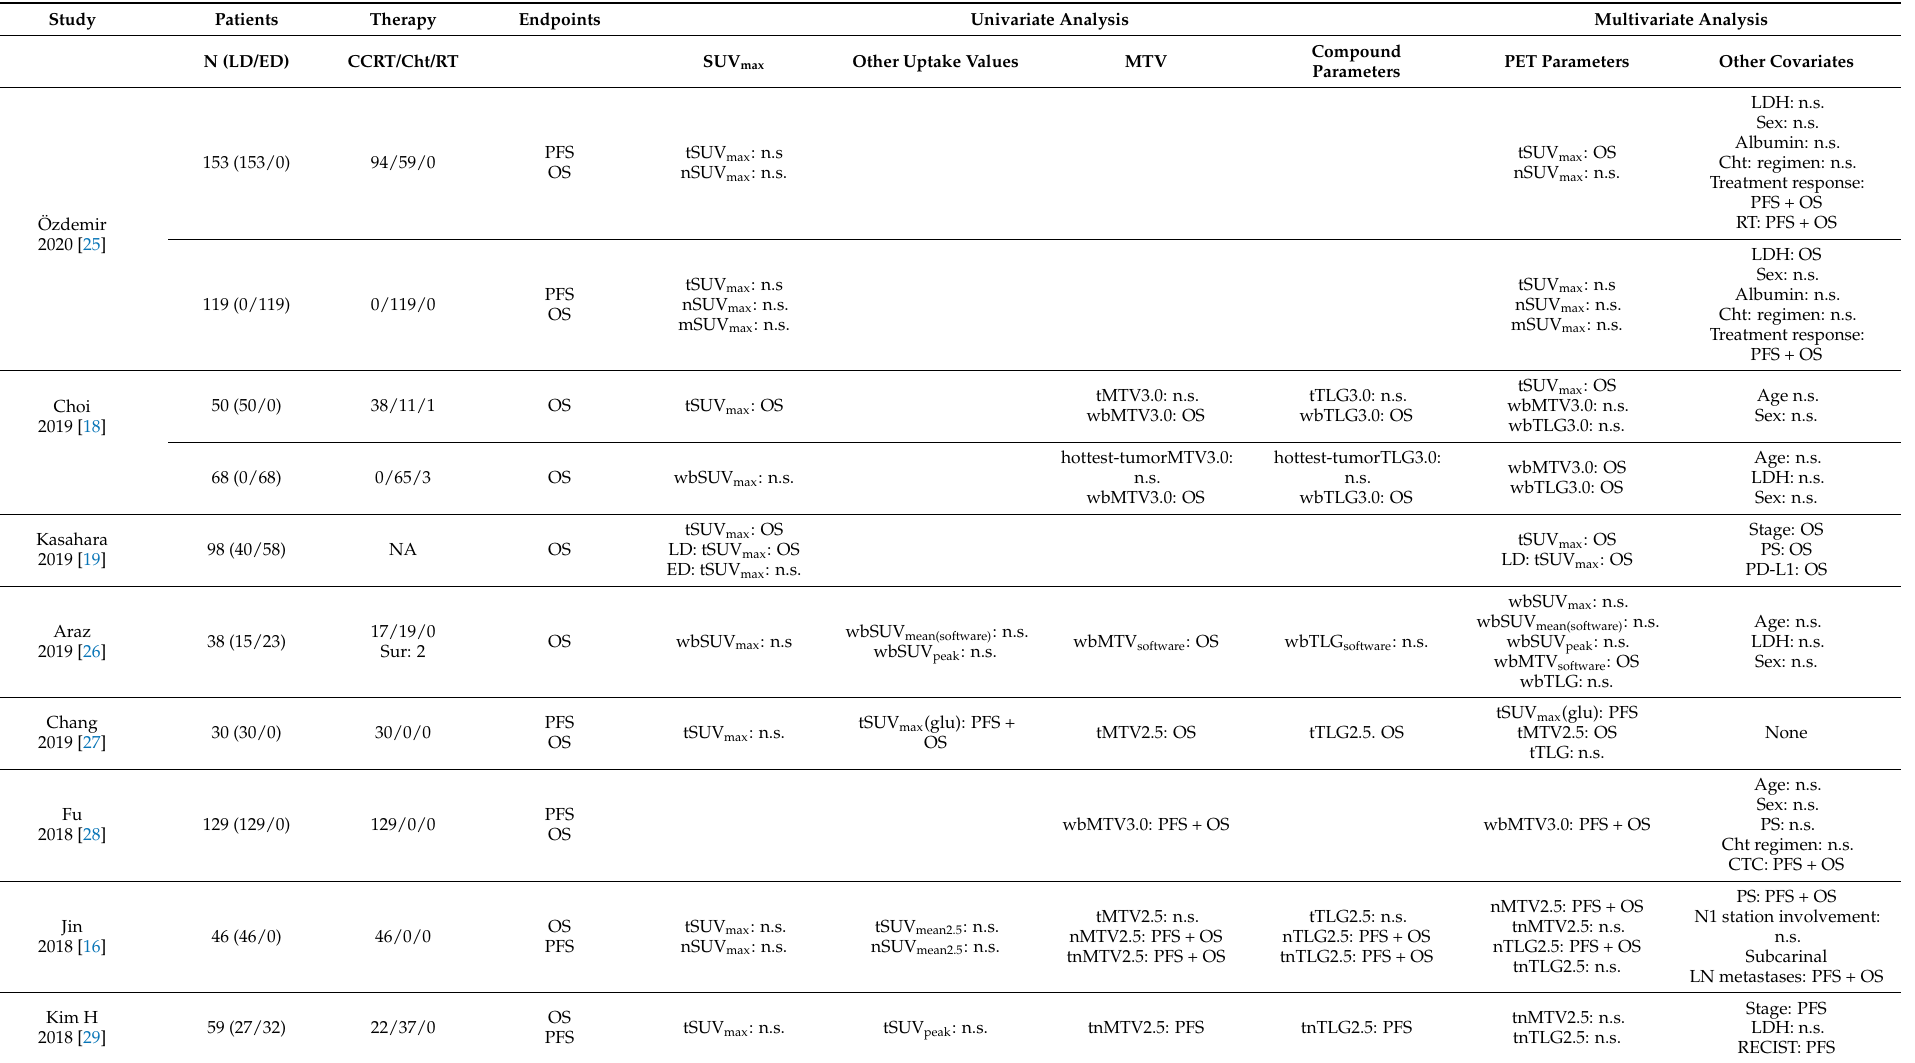
Table 2. Prognostic value of baseline PET